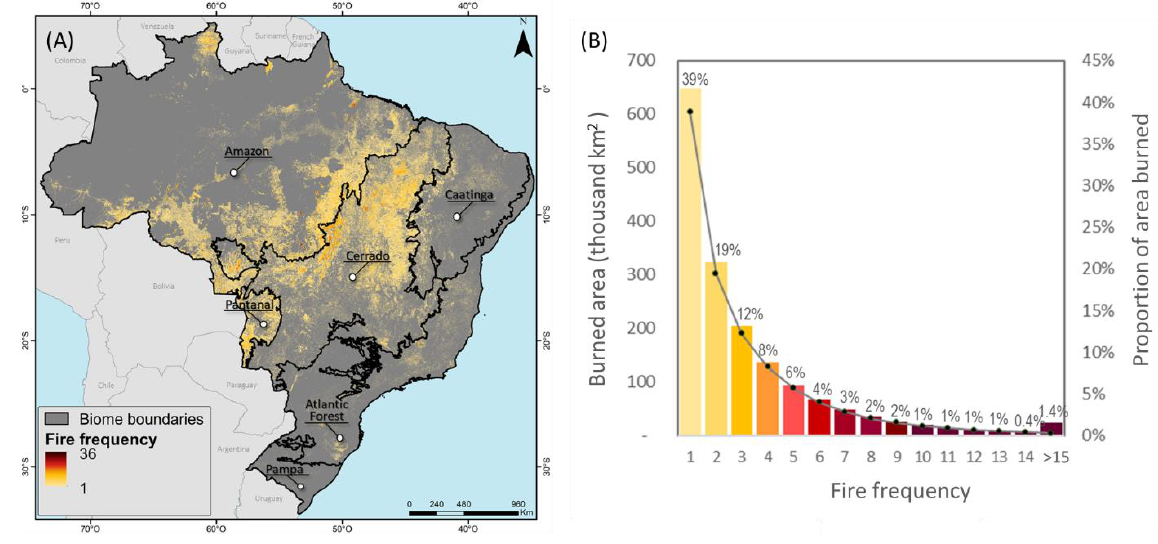
Figure 10. ( A ) Spatial distribution of fire frequency between 1985 and 2020 in Brazil, and ( B ) burned area and proportion of the burned area by frequency class. Table 2. Burned area (in square kilometers) in each frequency class, for each biome and for